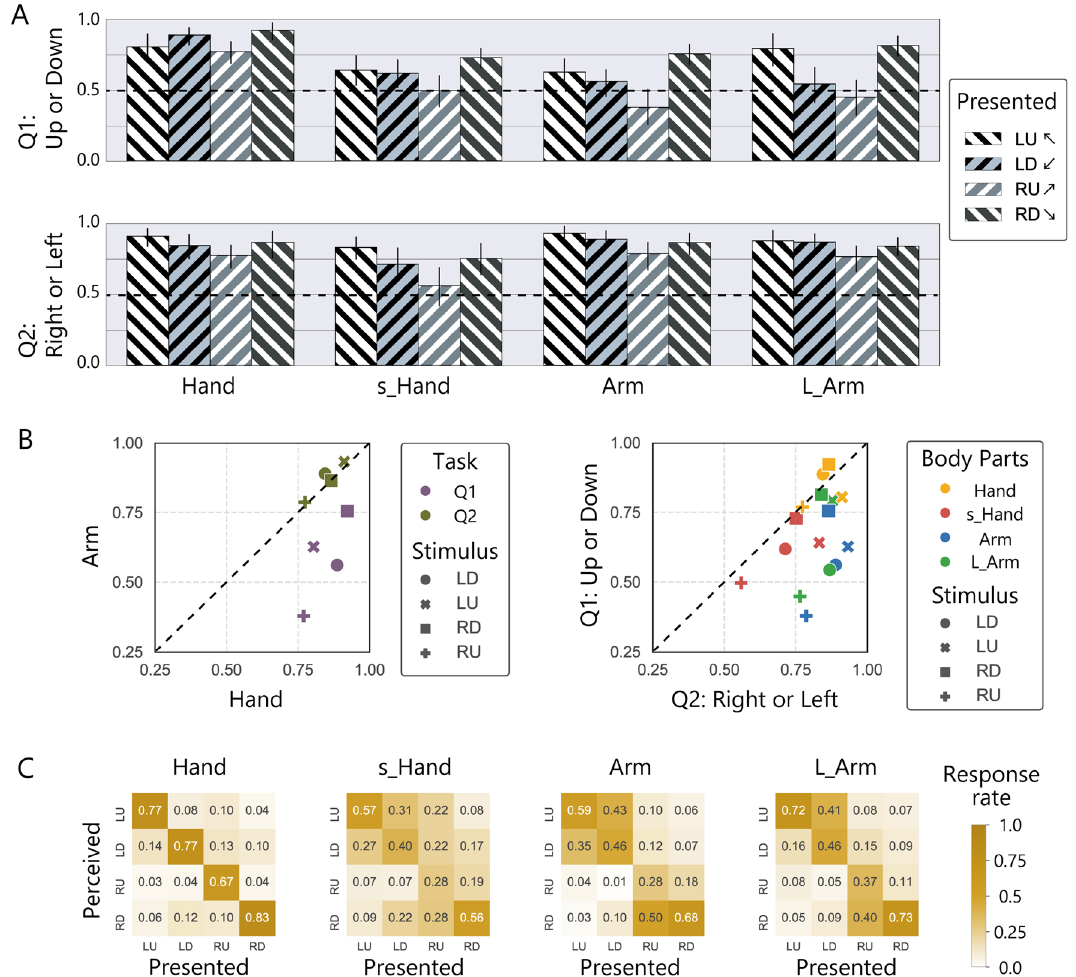
Figure 4. Results of Experiment 3 where nine dots were presented in a grouped manner like single large dot. ( A ) Averaged correct rates for each 2-AFC. Error bars represent 95% CIs. ( B ) The left panel represents the relationship of performance between the hand and arm conditions. The right panel represents the relationship of performance between the two 2-AFCs. ( C ) The estimated rate of the perceived